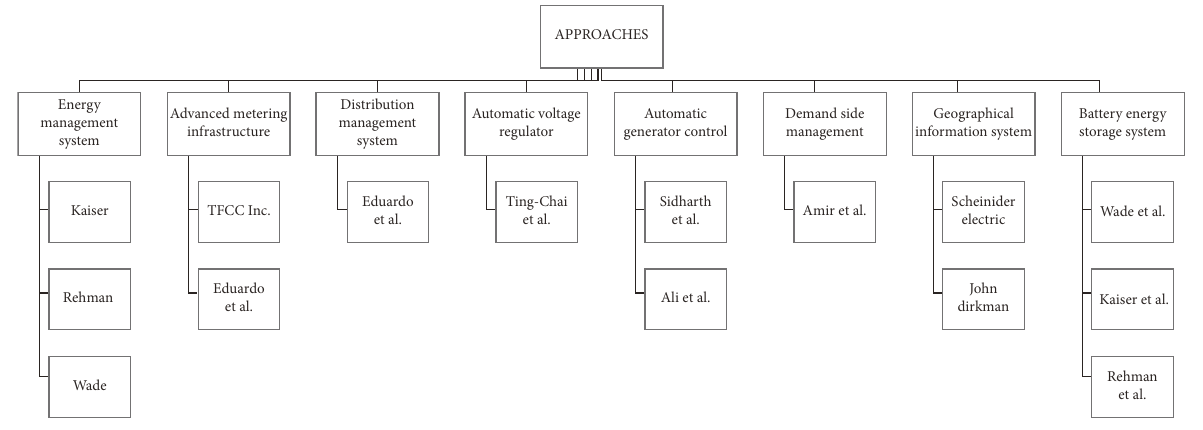
Figure 4: Different approaches to smart